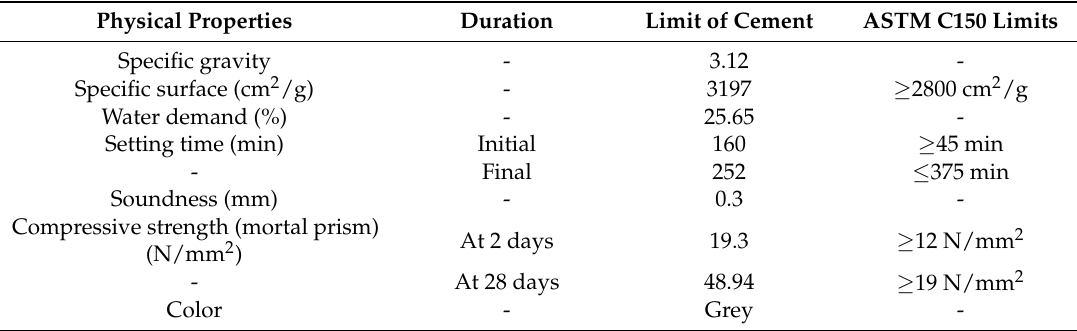
Table 2. Physical properties of cement.